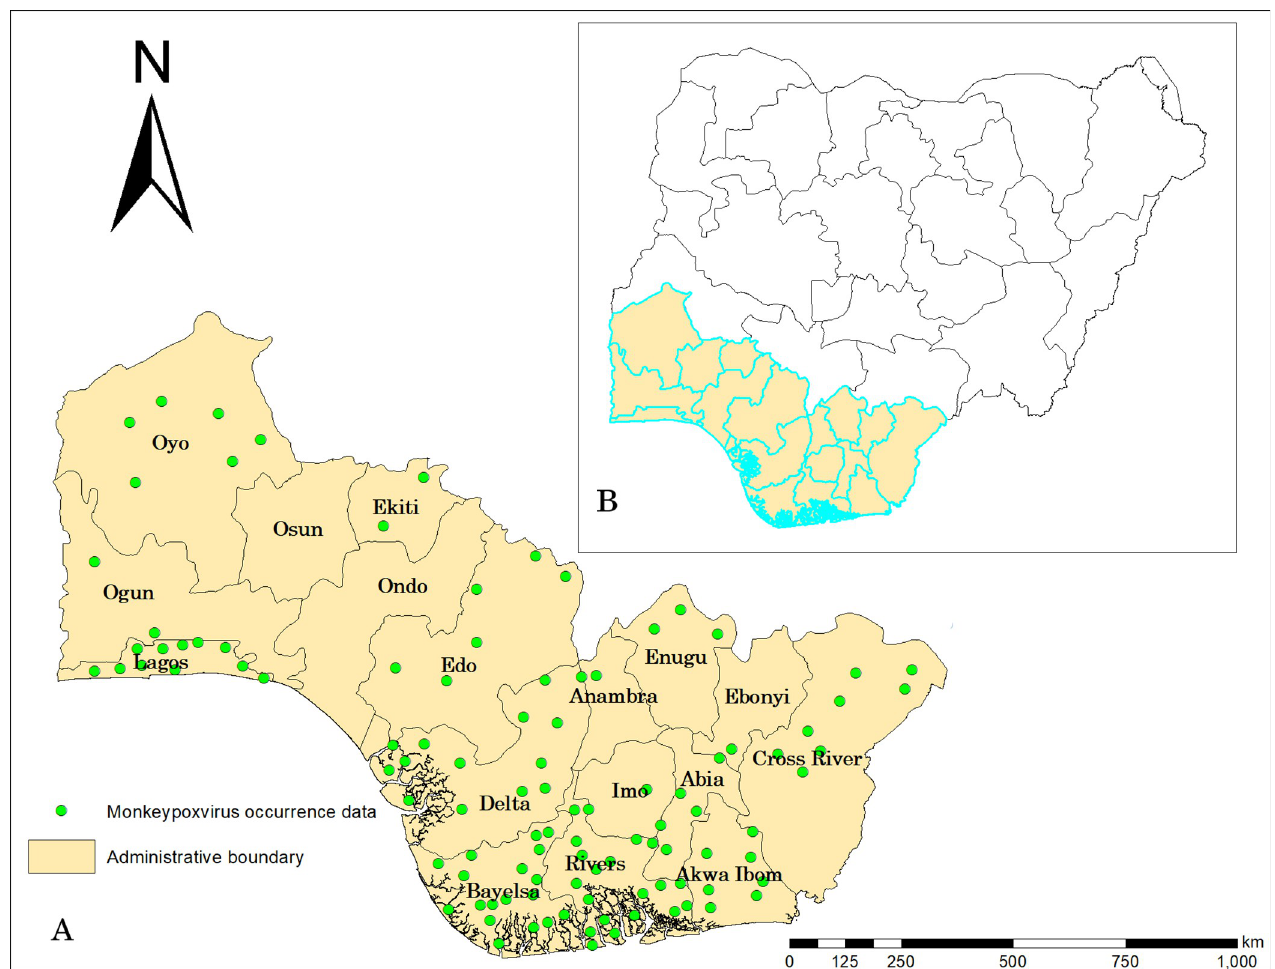
Fig 1. Study Area: A–Southern Nigeria; B–Nigeria (study area in red).